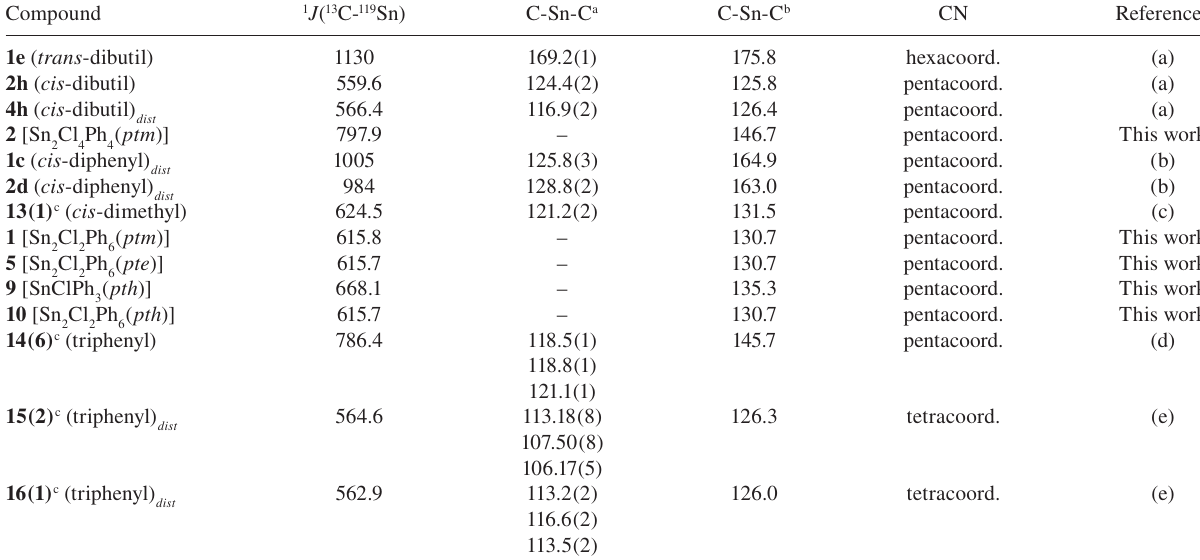
Table 1 1 J ( 13 C- 119 Sn) (Hz) and C-Sn-C bond angles of organotin(IV) compounds. Compound